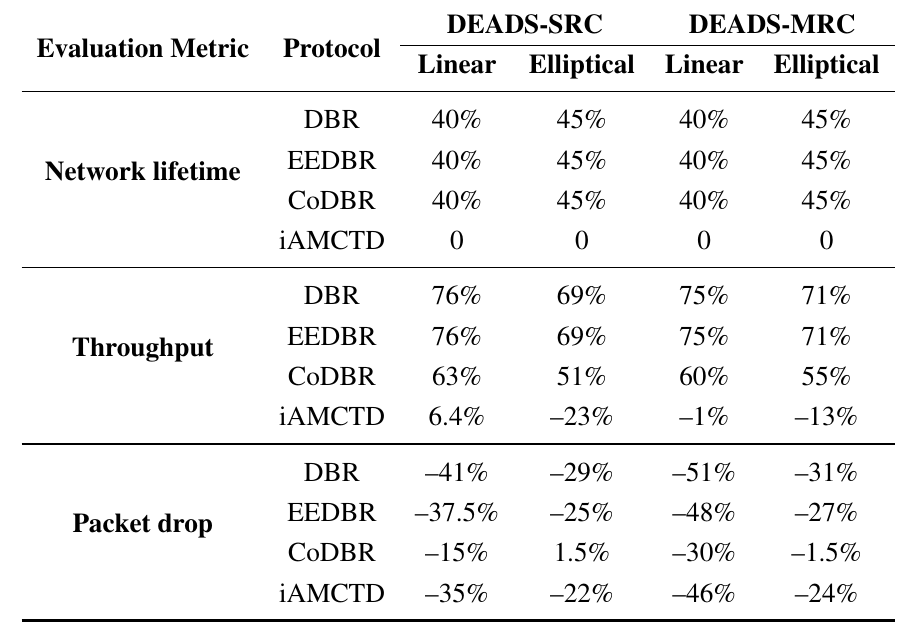
protocol. Network lifetime of the proposed scheme is same as iAMCTD but outperforms DBR and EEDBR. Highest throughput and lowest packet drop is achieved by DEADS-SRC and DEADS-MRC with linear mobility pattern of MSs. Table 2. Performance comparison of DEADS-SRC and DEADS-MRC with counterpart techniques. DEADS-SRC DEADS-MRC Evaluation Metric Protocol Linear Elliptical Linear Elliptical